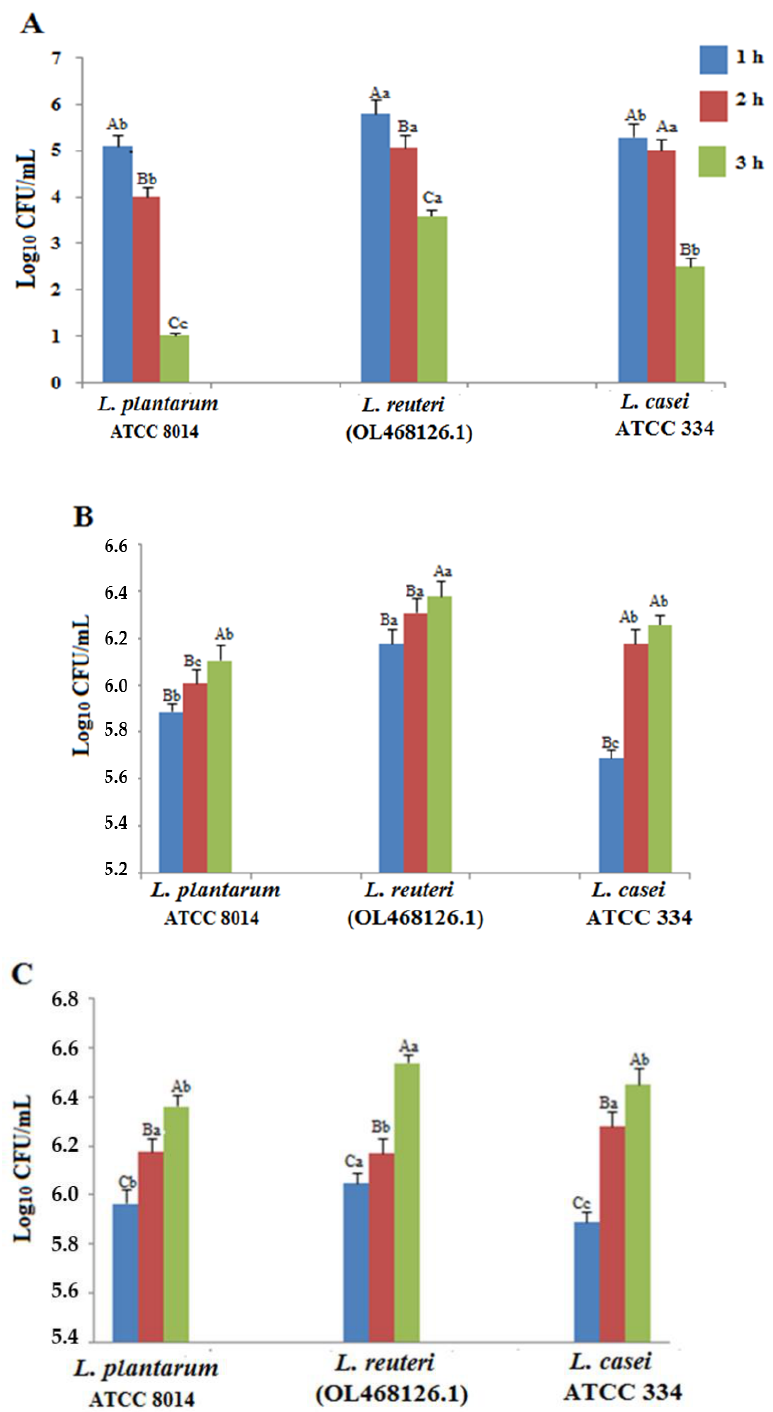
Figure 1. Tolerance of the isolated Limosilactobacillus reuteri (OL468126.1), Lactiplantibacillus plantarum ATCC 8014, and Lacticaseibacillus casei ATCC 334 to pH = 2 ( A ), pH = 3 ( B ), and pH = 5.8 ( C ) after 1, 2, and 3 h of incubation. Data are the mean values of three replicates, and the error bars indicate the standard deviation ( n = 3). Capital letters are used to indicate the significant differences observed for the same strain after different periods (1, 2, and 3 h). Different small letters indicate significant differences between the strains in the same condition ( p < 0.05).